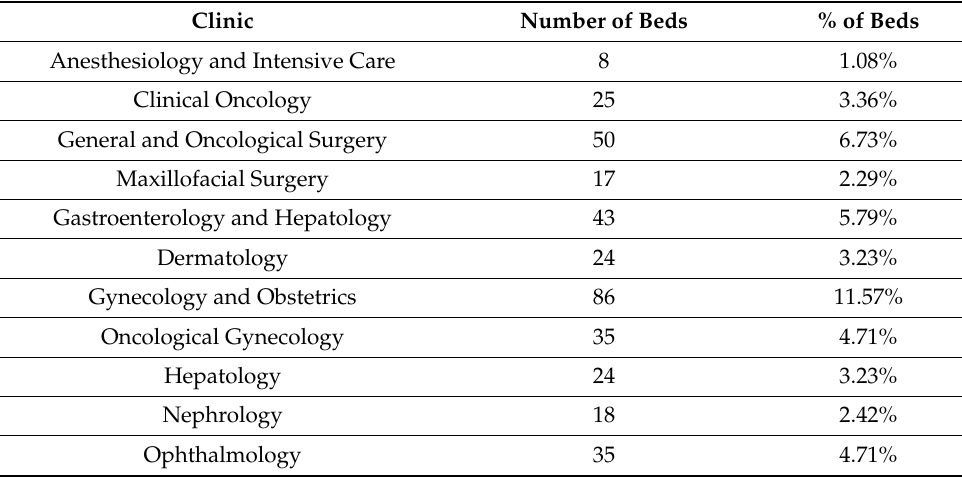
Table 1. Number of beds in the clinics of the analyzed hospital in 2017 (excluding day beds). Clinic Number of Beds % of